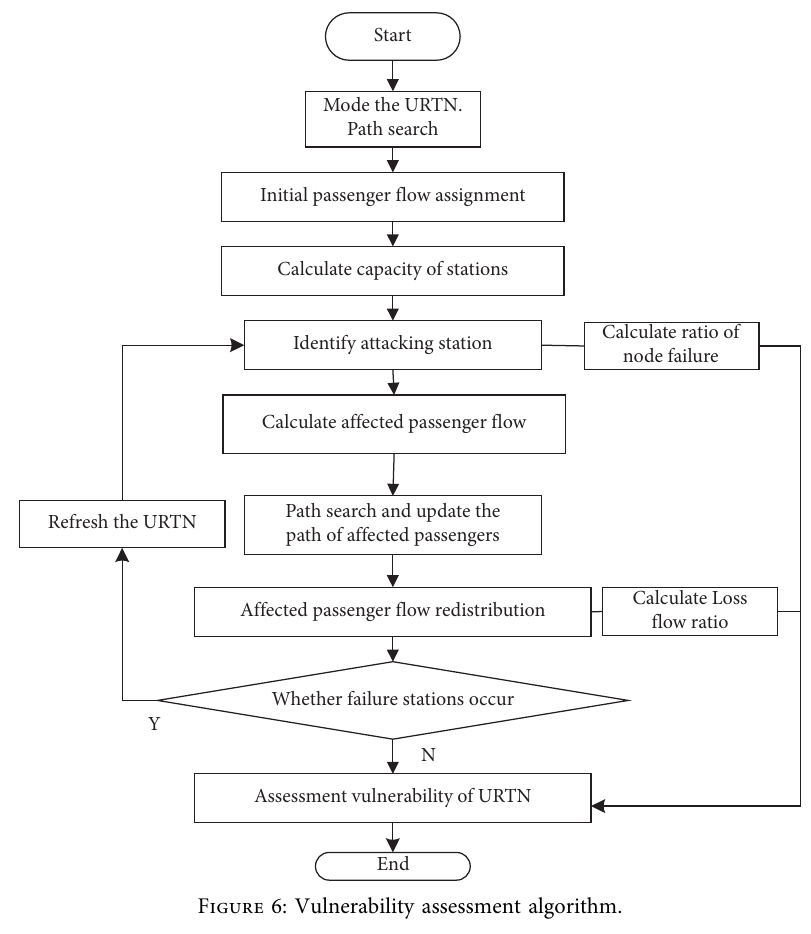
Figure 6: Vulnerability assessment